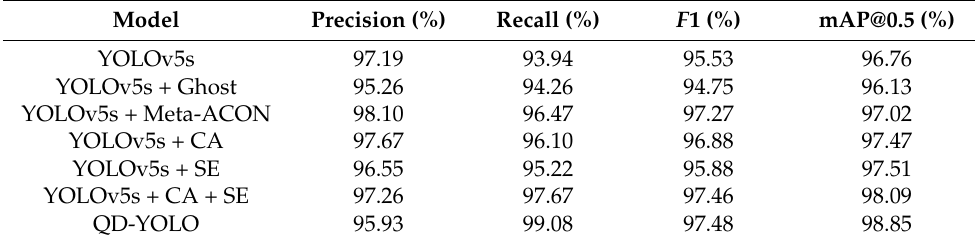
Table 4. Comparison of Ghost convolution optimization performance.